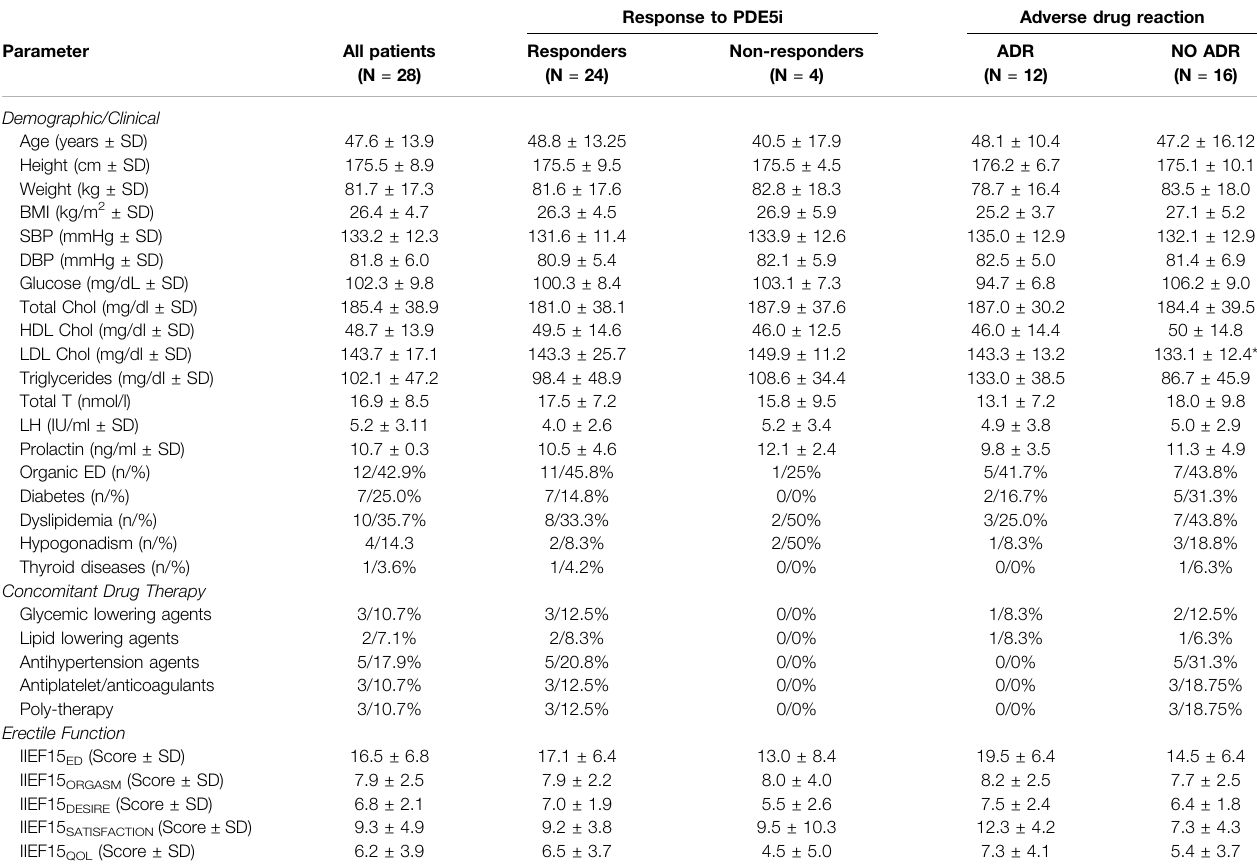
TABLE 1 | Basal demographic and clinical parameters of patients with erectile dysfunction included in the group, distinguished for response to type fi ve phosphodiesterase inhibitors and related adverse drug